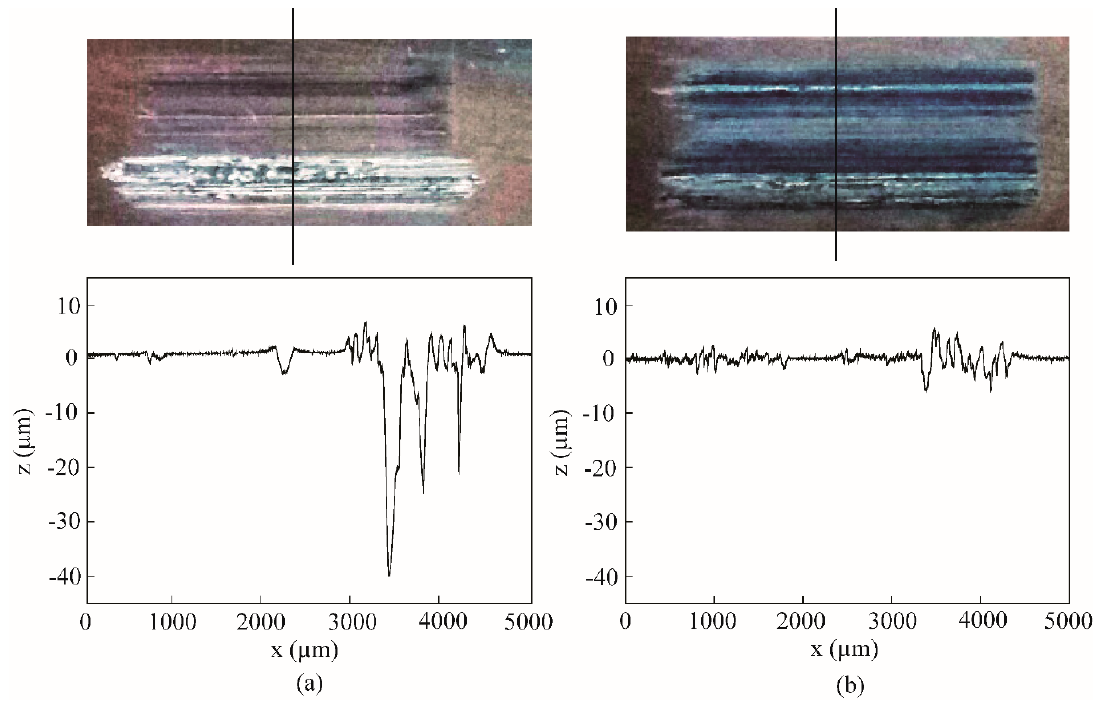
Figure 13. Wear scar images and 2D profile curves of worn surface lubricated by ( a ) the base oil and ( b ) the base oil with 1.0 wt% ZrS 2 additives at 150 °C.